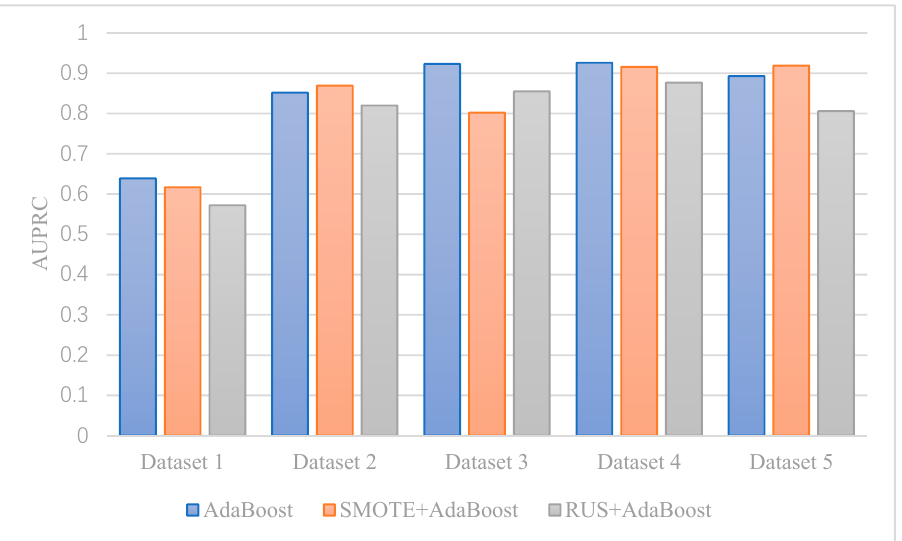
Int. J. Environ. Res. Public Health 2020 , 17 , x FOR PEER REVIEW Figure 5. The impact of resampling on AdaBoost. Figure 5. The impact of resampling on AdaBoost.